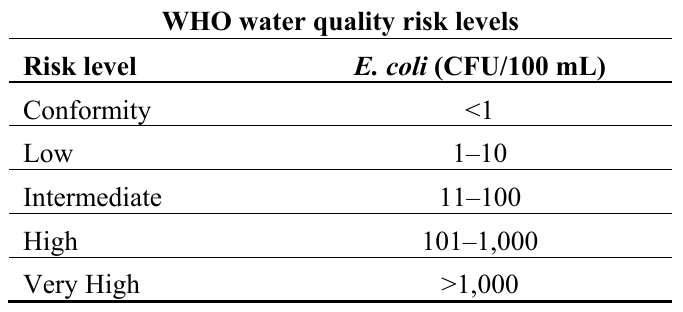
Table 3. WHO water quality risk levels (Reprinted from [24] with